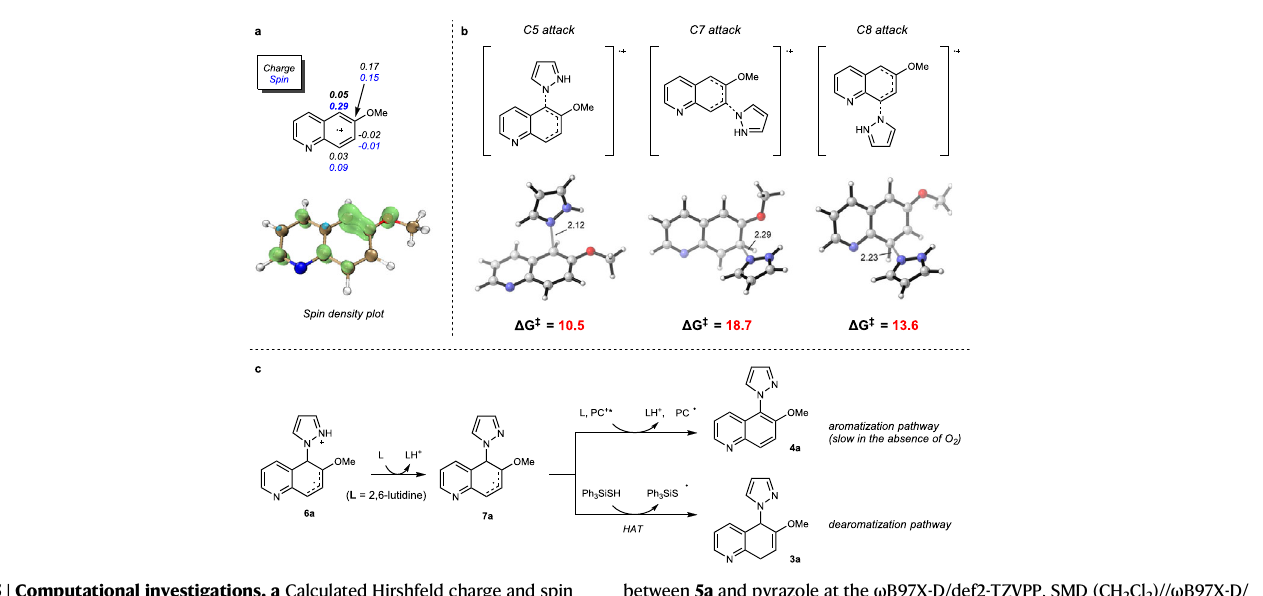
Fig. 5 | Computational investigations. a Calculated Hirshfeld charge and spin densitiesofradicalcation 5a atthe ω B97X-D/def2-TZVPP,SMD(CH 2 Cl 2 )// ω B97X-D/ def2-SVPleveloftheory. b CalculatedC – Nformingtransitionstatesforthereaction